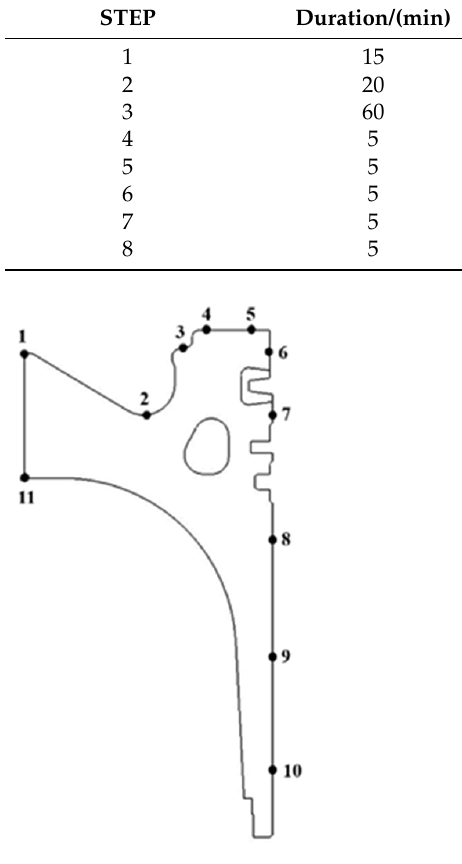
Table 4. The operation process to load condition.